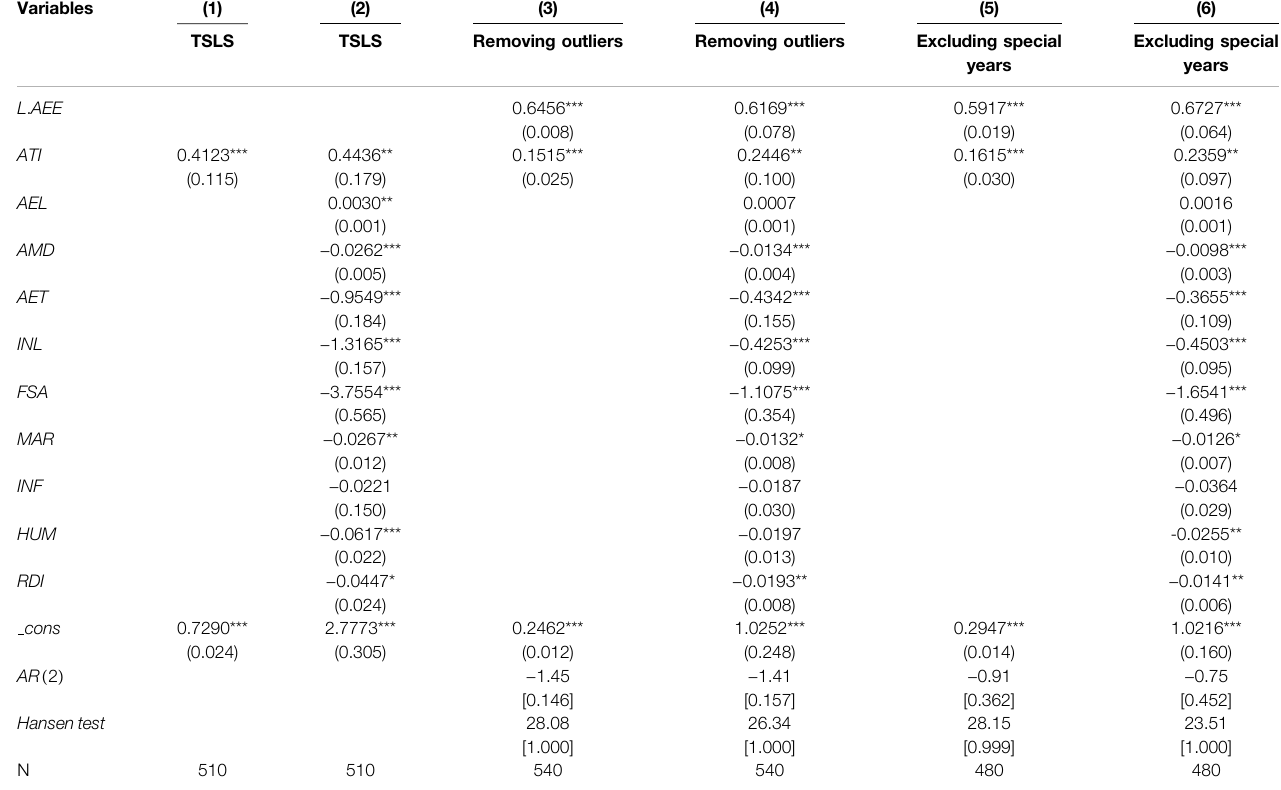
TABLE 5 | Robustness